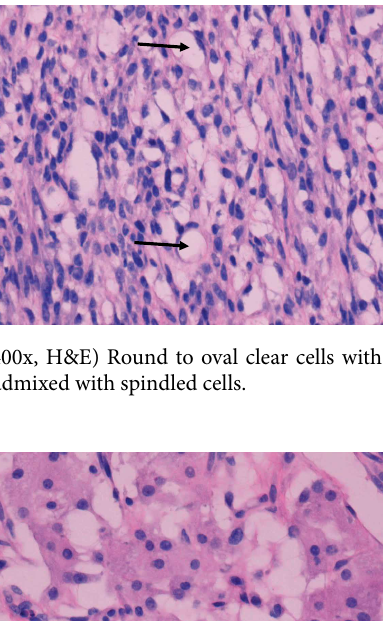
Figure 8: Microscopic section on (400x, H&E) reveals stromal cells with rare mitotic figure (black